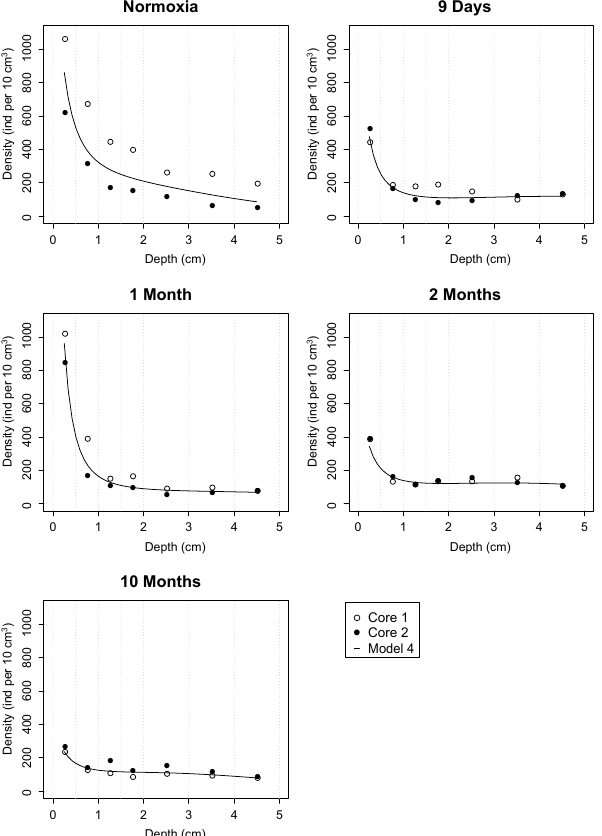
Fig. 3. Foraminiferal density plotted against sediment depth for all sampled cores. Open circles represent the density in replicate core 1, filled black circles that in core 2. Solid black line represents the modeled density according to model 4.